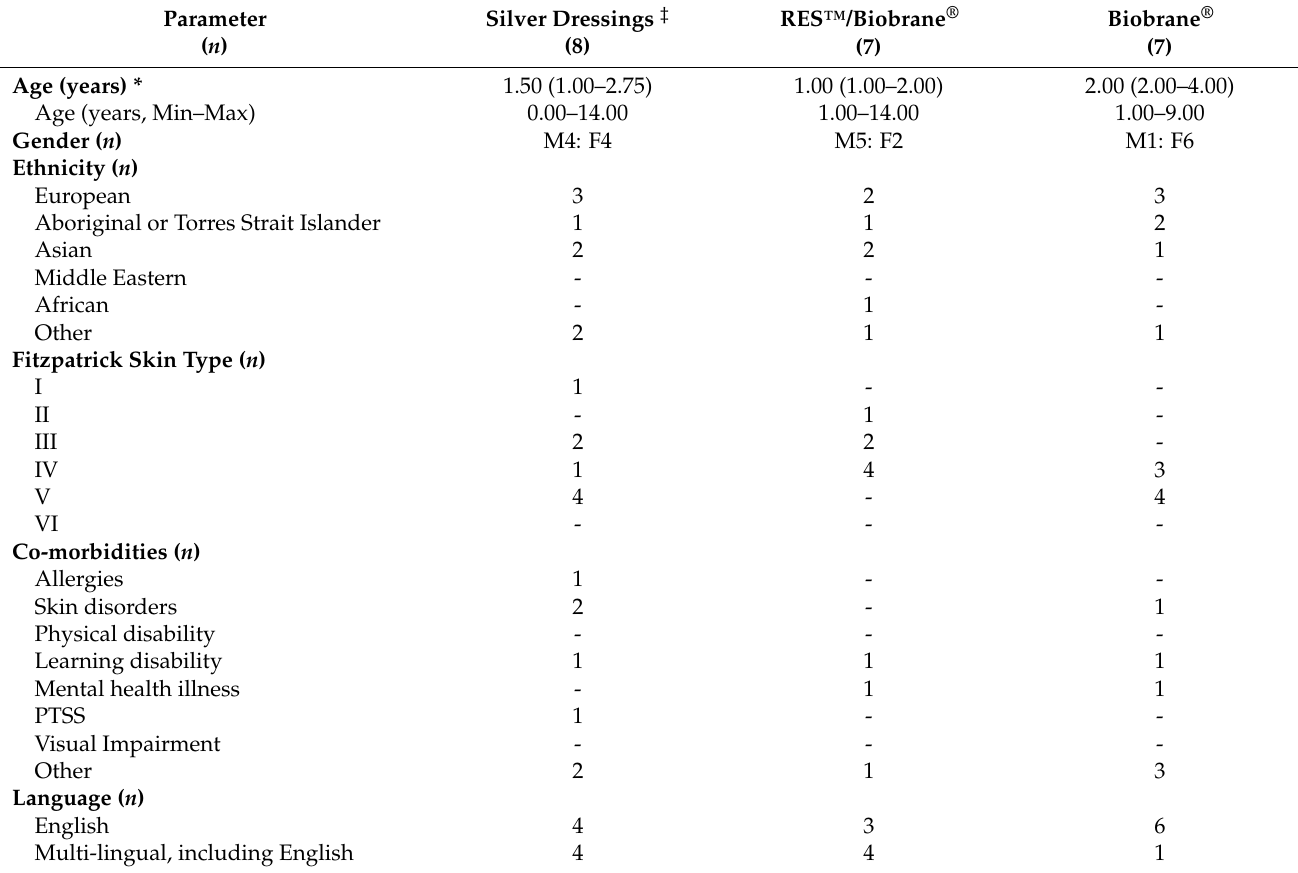
Table 1. Baseline participant